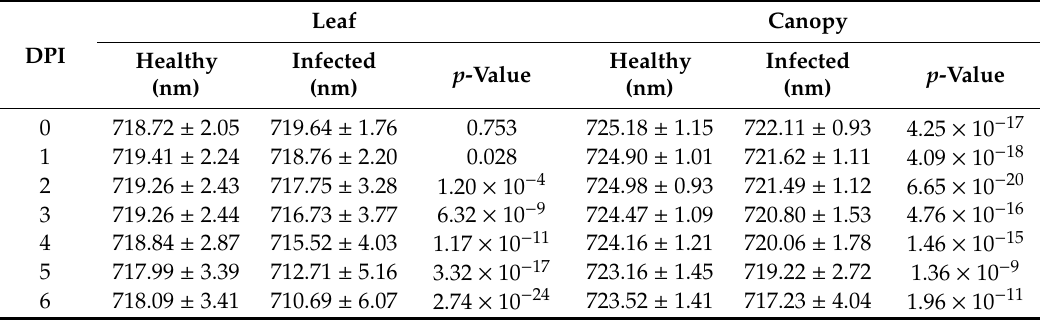
Table 2. Mean and standard variation of the red-edge point (REP) wavelength (in nm) and p -values for the t -test for mean comparison in the case of the leaf and canopy measurements as a function of the number of days post-inoculation (DPI).